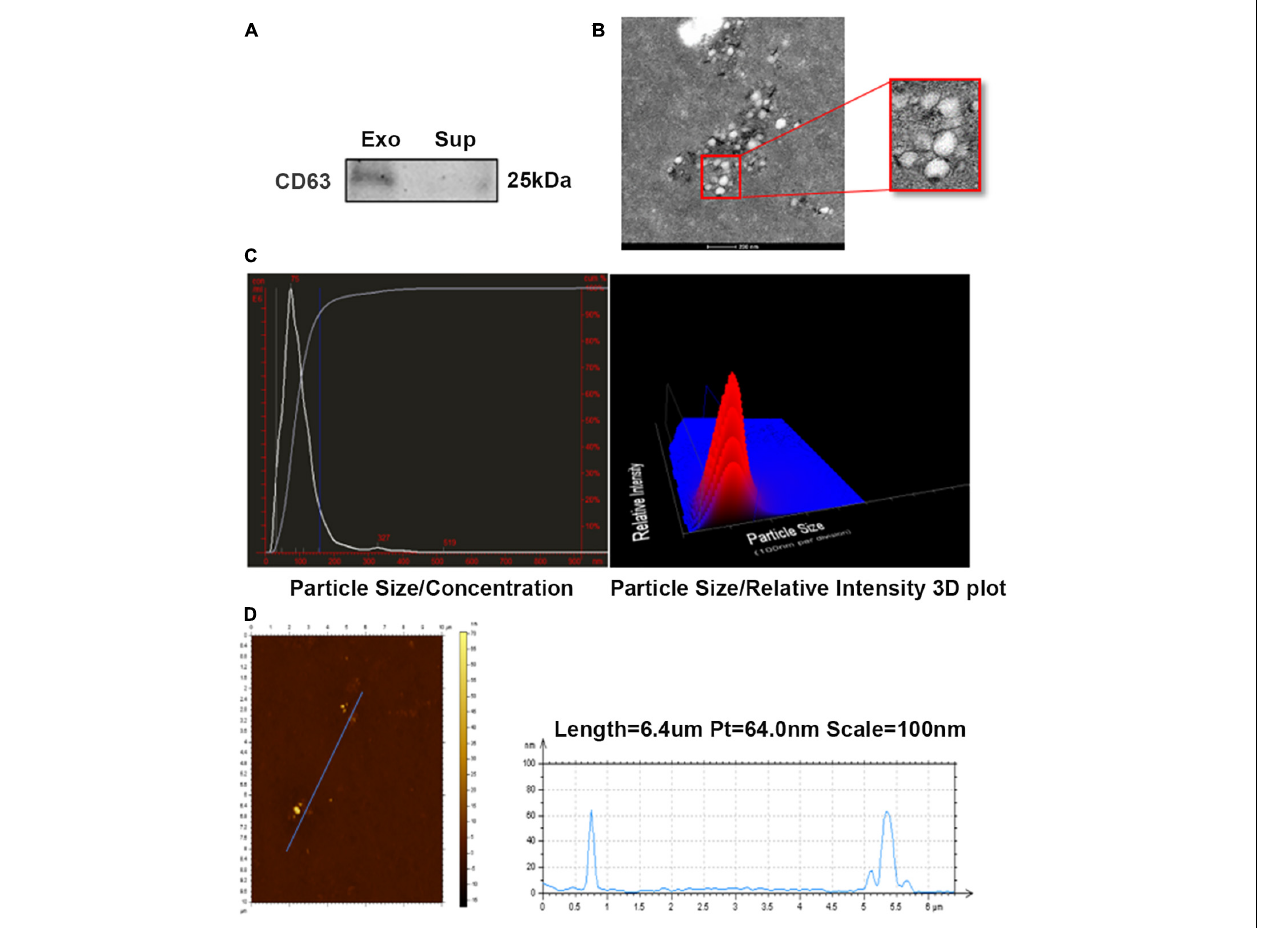
FIGURE 1 | Characterization of ADSC-exosomes. (A) Western blot analysis of CD63 expression in ADSC exosomes. (B) TEM analysis of exosomes secreted by ADSCs. Scale bar = 200 nm. (C,D) The particle size of the exosomes secreted by ADSCs was measured by NanoSight LM10 and AFM5500. ADSC, adipose-derived mesenchymal stem cells; TEM, transmission electron